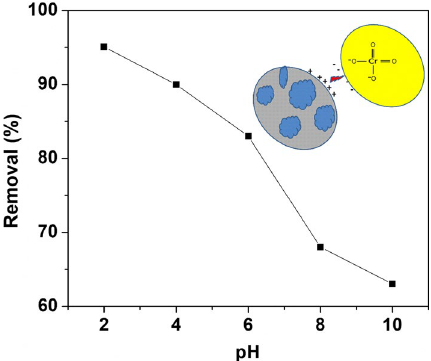
Fig. 6 Effect of pH on the adsorption removal efficiency of CTAB– kaolin ( inset: the plausible electrostatic adsorption mechanism between CTAB–kaolin and CrO 4 − )